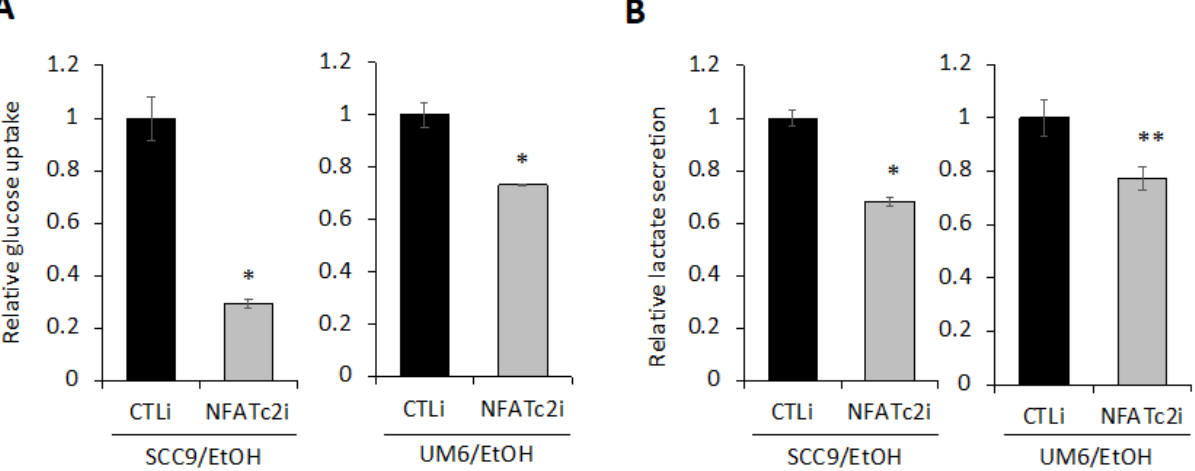
Figure 7. Knockdown of NFATc2 inhibits the glycolytic activity in the EtOH-exposed OSCC. ( A ) Effect of NFATc2 knockdown on glucose uptake in the EtOH-exposed OSCC cells (SCC9/EtOH and UM6/EtOH) was determined using a Glucose-Glo ™ assay kit. ( B ) Effect of NFATc2 knockdown on lactate secretion in the EtOH-exposed OSCC cells was determined using Lactate-Glo ™ assay. * p < 0.001 and ** p < 0.05.